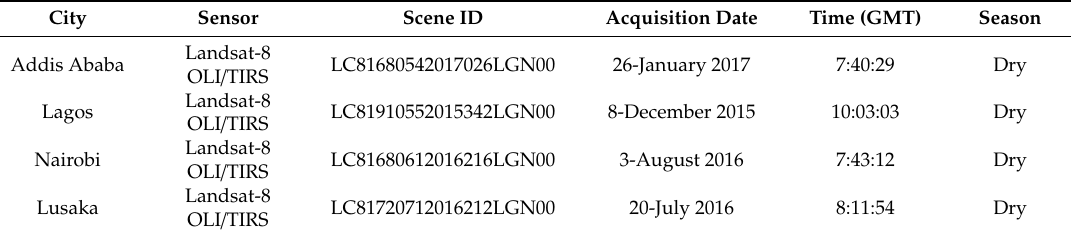
Table 1. Details of the Landsat-8 imagery